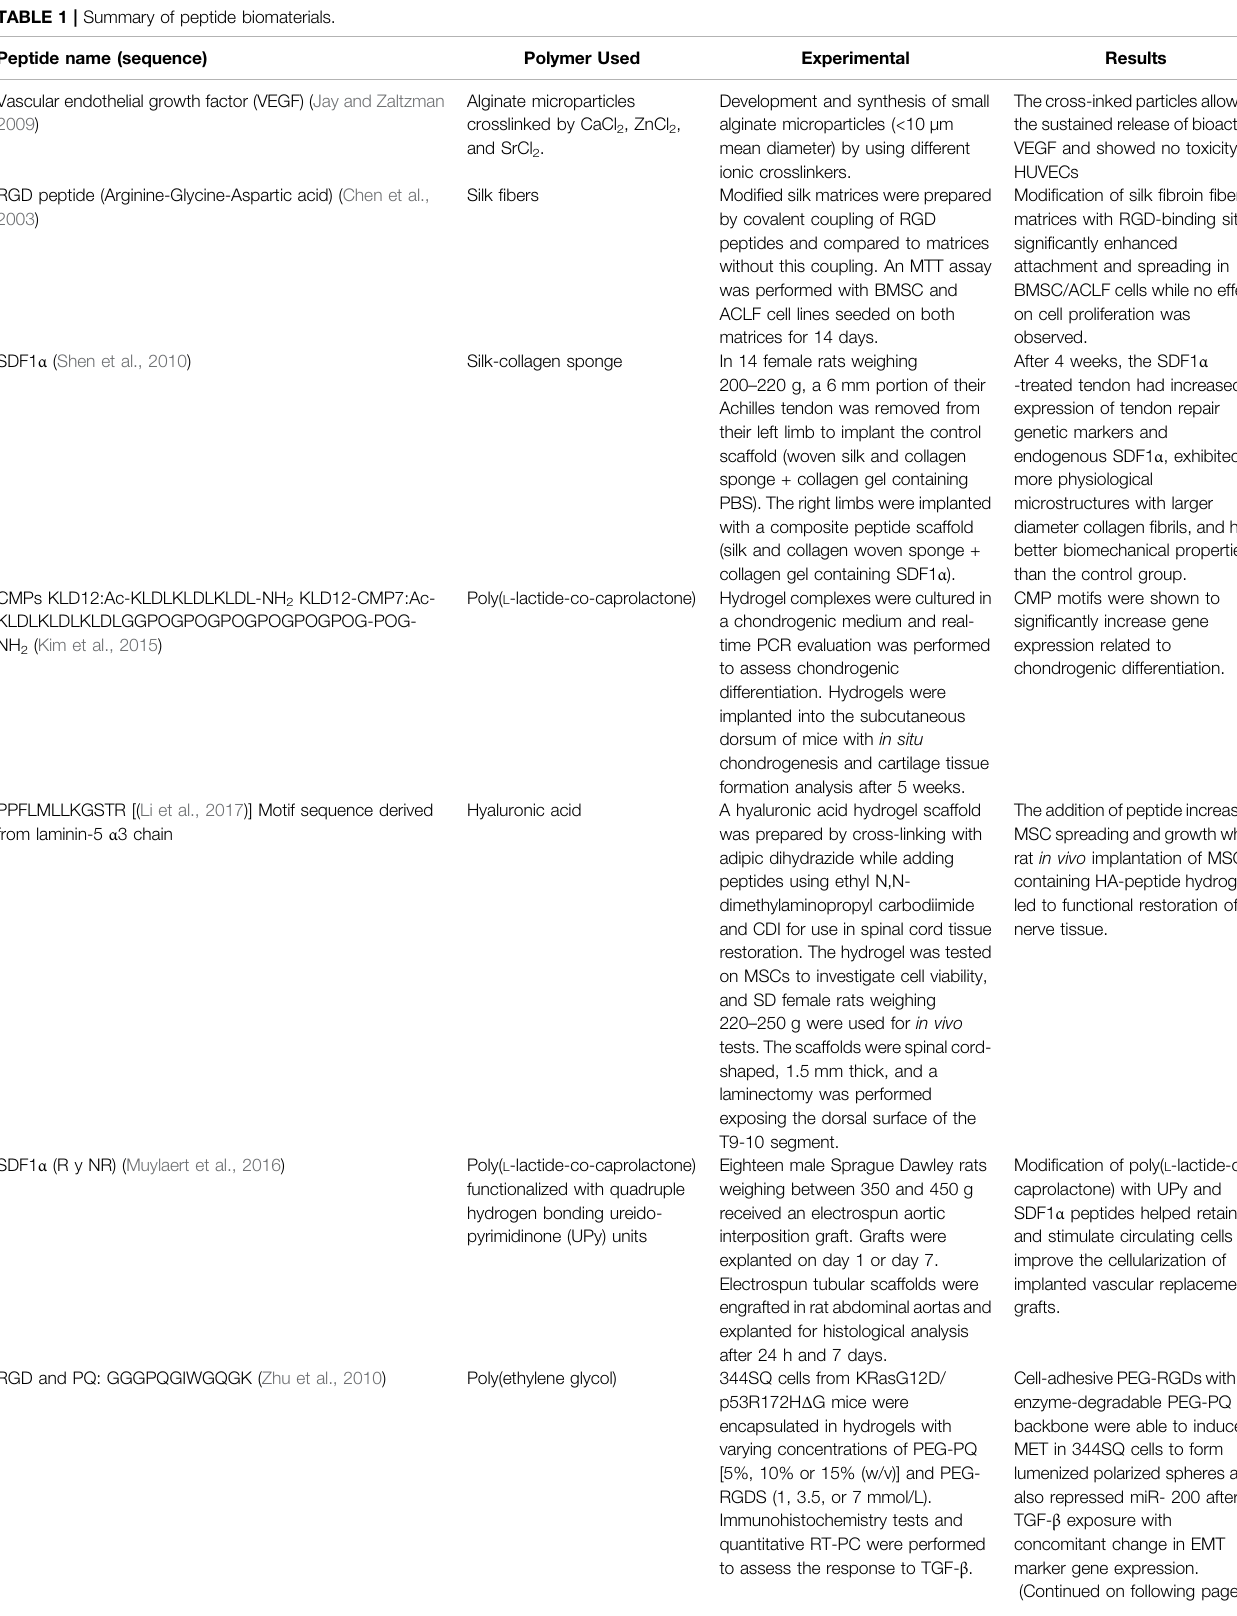
TABLE 1 | Summary of peptide biomaterials. Peptide name